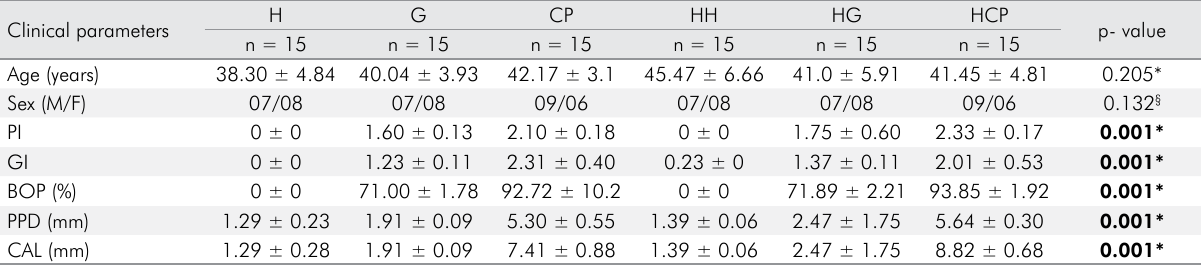
Table 1. Periodontal clinical measurements of sampling sites of the study groups. Clinical